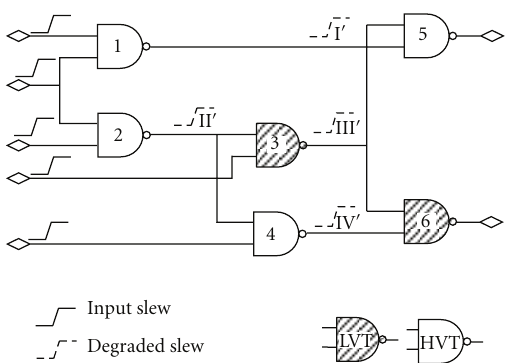
Figure 8: Hypothetical circuit with HVT and LVT cells for exem- plification.